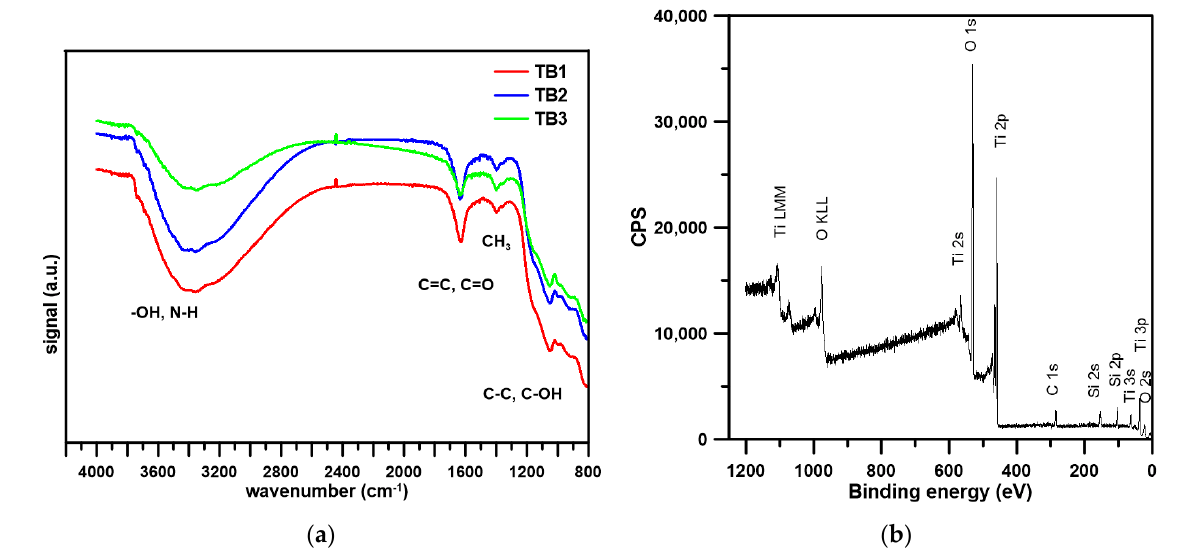
Materials 2023 , 16 , x FOR PEER REVIEW Figure 2. Physicochemical characteristics of tested: ( a ) FTIR spectra; ( b ) XPS spectrum of TB2.